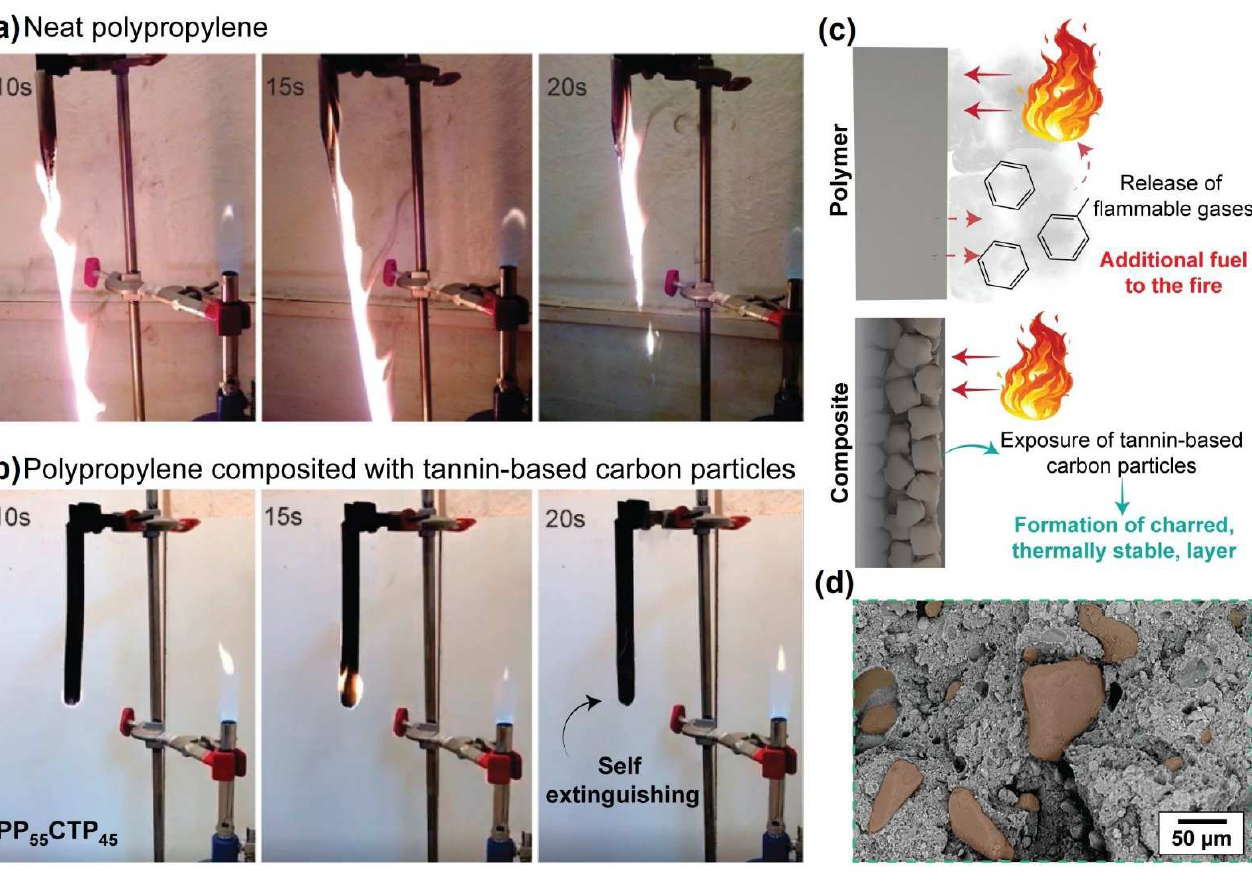
Figure 5. Behavior of ( a ) neat PP and ( a , b ) PP-CTP composite during combustion assays. ( c ) Proposed mechanism of flame development and burning process of the PP matrix and PP-CTP composites. ( d ) SEM image of the PP-CTP composite after burning displays the formation of the charred layer, and exposure of tannin microparticles (highlighted in brown) that induce flame extinguishing. Table 2. Flammability results for the neat PP, controls, and CTP-filled